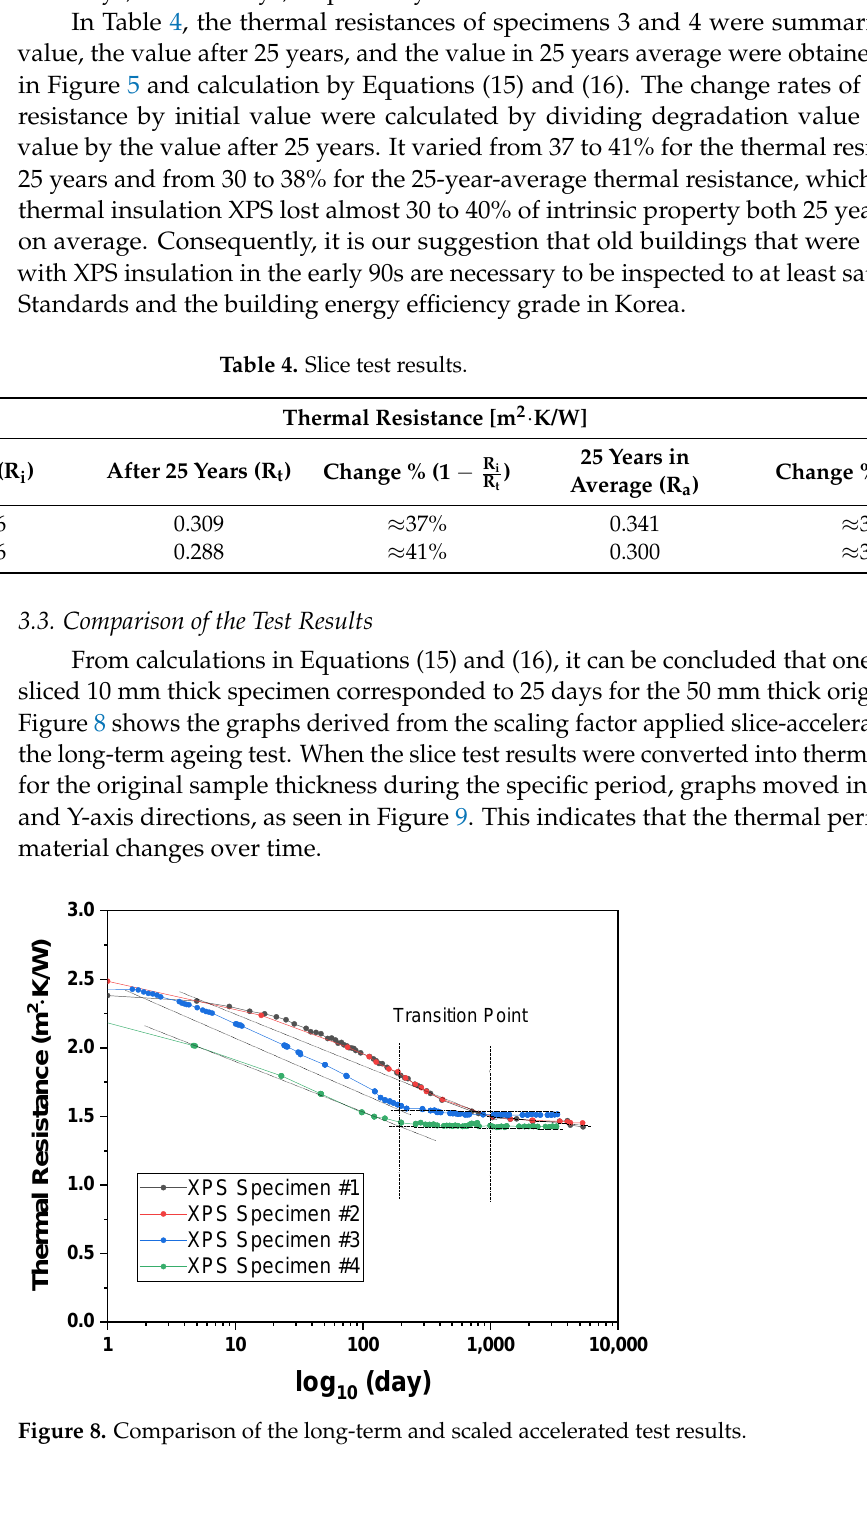
Transition Point Figure 9. Comparison of measurement results on converting them to results for a thickness of 50 mm. The transition point was observed to occur after approximately 1,000 and 5,000 days for the long-term test and accelerated test results, respectively, thereby indicating a sig- nificant time difference between the two results. The difference between the two results was settled within 10% at around the time after 3,600 days. 4. Conclusions The hypothesis raised by ISO 11561 states that the thermal resistance of a sliced sam- ple after 25 years and the 25-year average thermal resistance were degraded by time. It also specifies that the anticipated results may differ by approximately 10% compared to the original thickness sample. Based on this hypothesis, we compared the long-term age- ing test data with the actual elapsed time. When the minimum period to consider the re- modeling of an old building was assumed to be 3,600 days (10 years), the prediction of